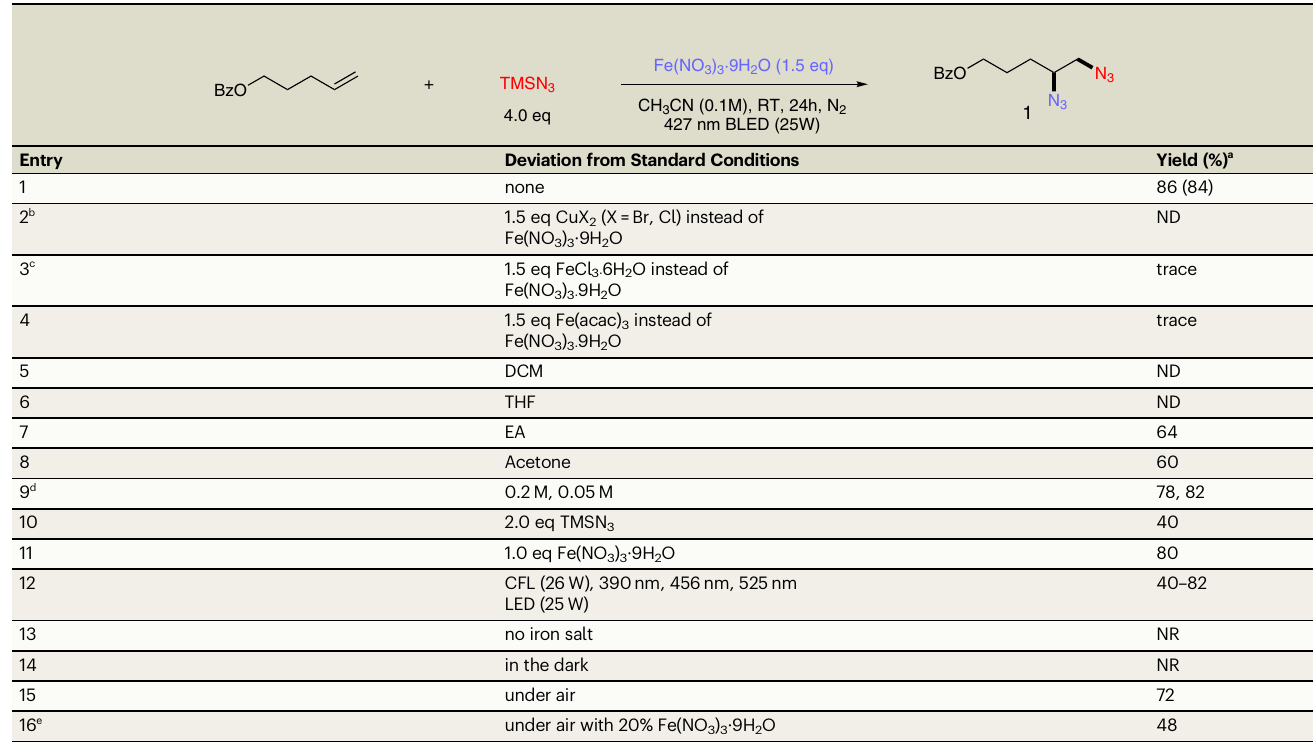
Table 1 | Optimization of reaction